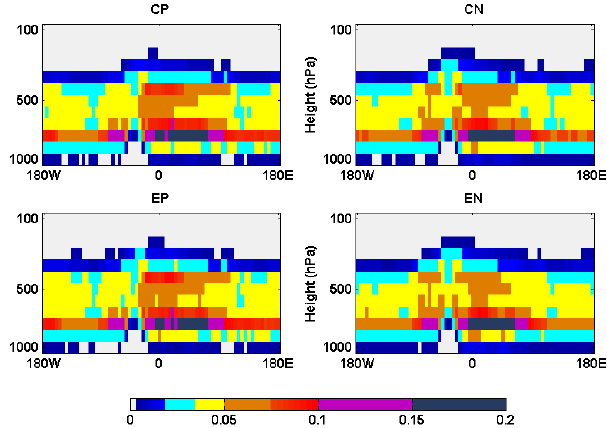
Fig. 3: Climatological effective cloud fraction derived from AIRS (2002-2011) averaged Fig. 3. Climatological effective cloud fraction derived from AIRS over 67N-82N. Note that the colourbar is adapted to highlight differences in cloud (2002–2011) averaged over 67–82 ◦ N. Note that the colourbar is adapted to highlight differences in cloud fraction.